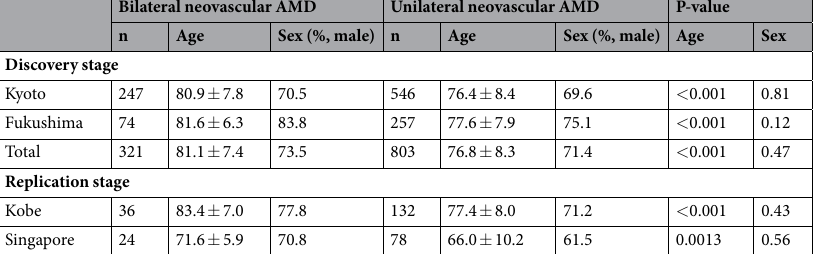
Table 1. Neovascular age-related macular degeneration samples used in the study